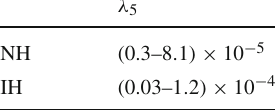
left panel corresponds to normal hierachy (NH) of neutrino mass spectrum and the right panel to the case of inverted hierarchy (IH). The horizontal solid black line labelled as “ (cid:12) L observed” correspond to the value of (cid:12) L that is par-